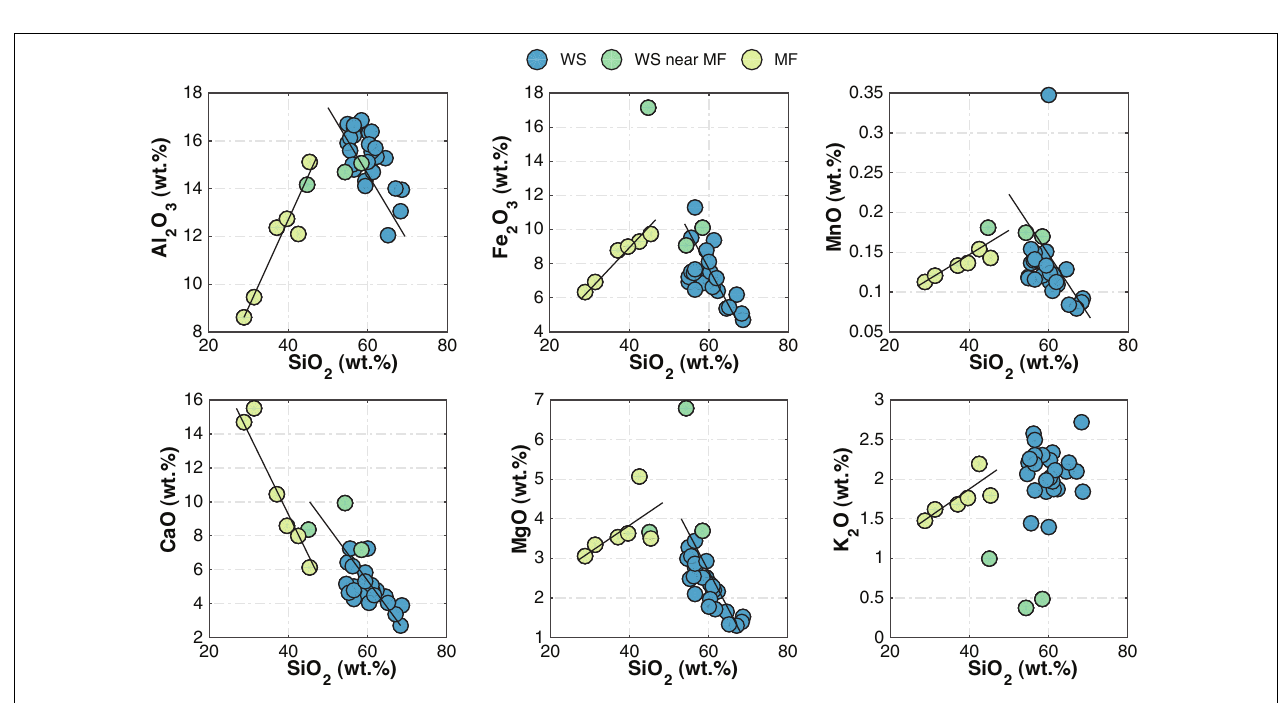
FIGURE 5 | Relationships between major element oxide and SiO 2 contents in WS and MF samples. WS, modern watershed; and MF, modern mudflat.